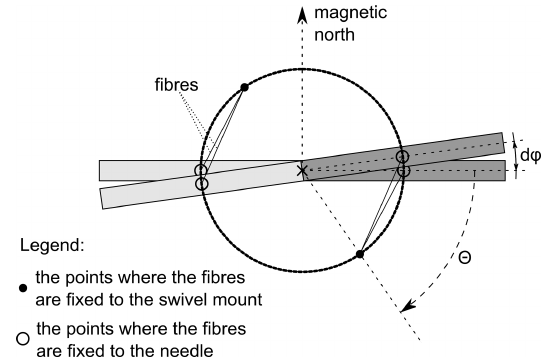
Figure 3. Changing the position of the needle by a small angle d ϕ when the geomagnetic field increases (view from above). If the magnetic field weakens, the deflection d ϕ is in the opposite direc-